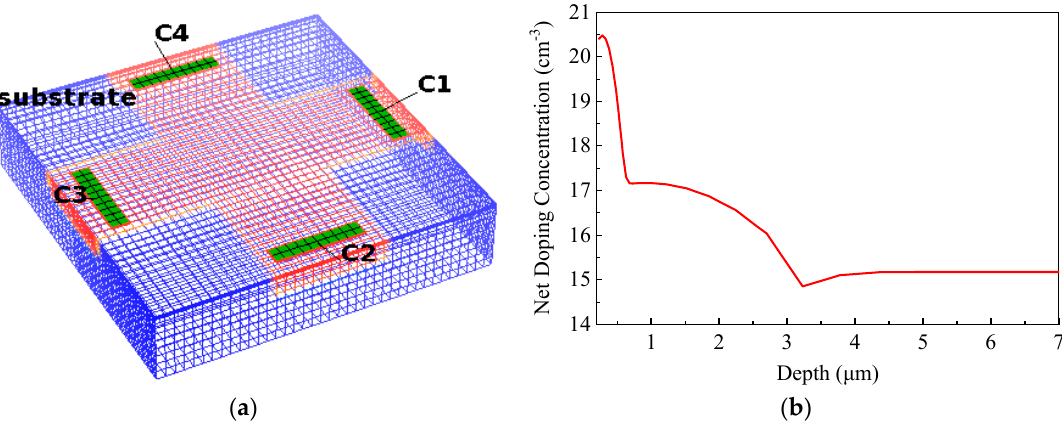
Figure 6. Technology Computer Aided Design (TCAD) simulation model using Silvaco Atlas tool. ( a ) 3D device simulation structure of the cross-like Hall plate; ( b ) 1D net doping profile in the device active region.